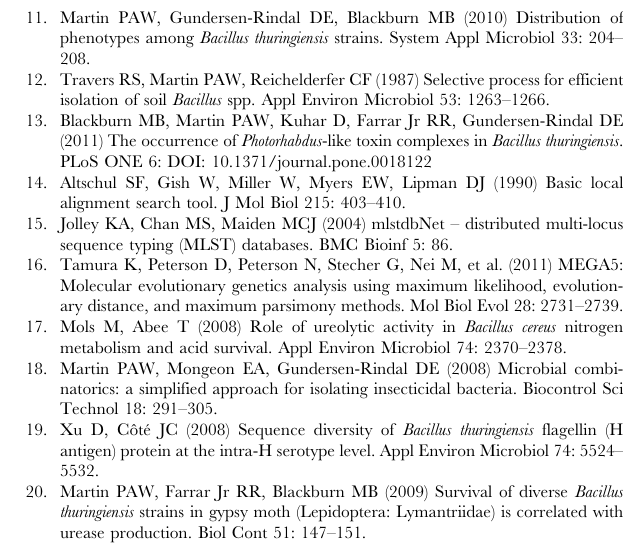
Figure S1 Maximum likelihood analysis of sequence types 1–594.